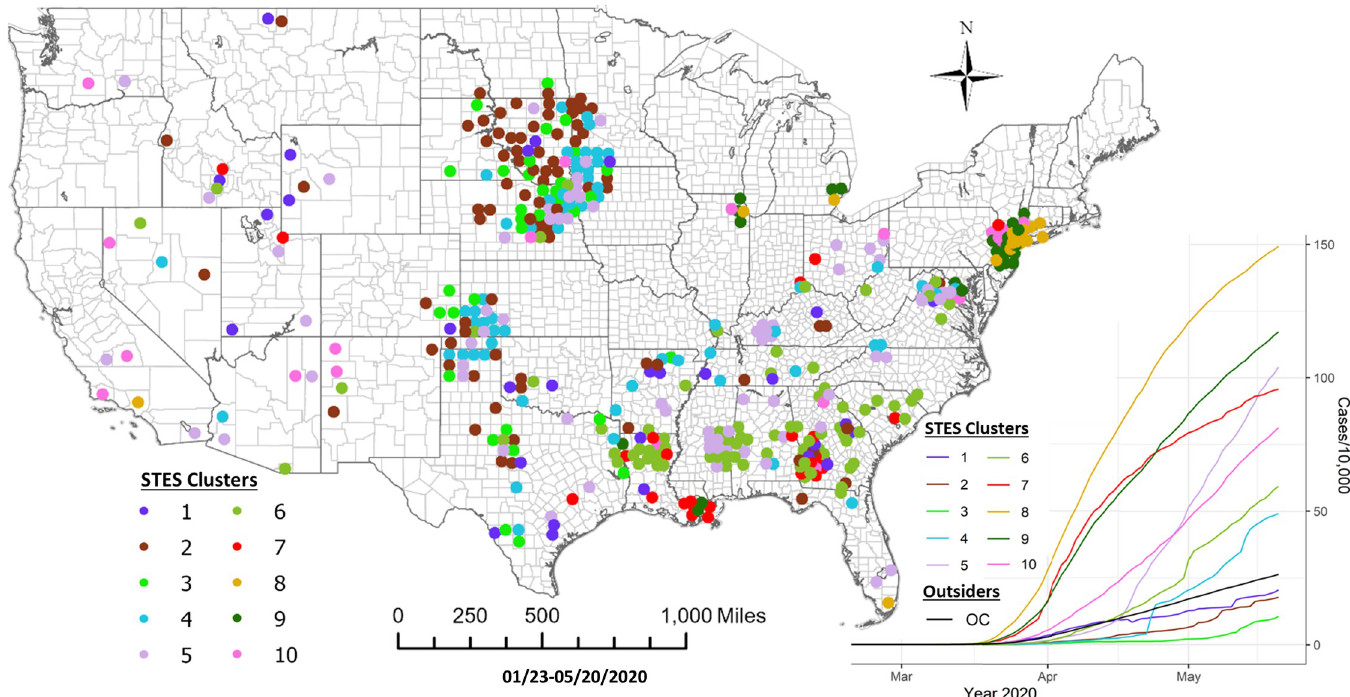
Fig 12. Sequence similarity-based COVID-19 clusters along with average temporal trends at county level during 1/22/-5/20/2020. This map includes the counties with higher relative risk (RR > 1) contained in all the clusters detected by scan statistics in Fig 10. The average temporal trends of cumulative cases for STES clusters 1–10 on the map appear at the bottom right. Notice that the colors of STES clusters match with correspondingly colored dots on the map and with the colors of the STES cluster curves on the graph. OC includes all counties not included in the clusters.